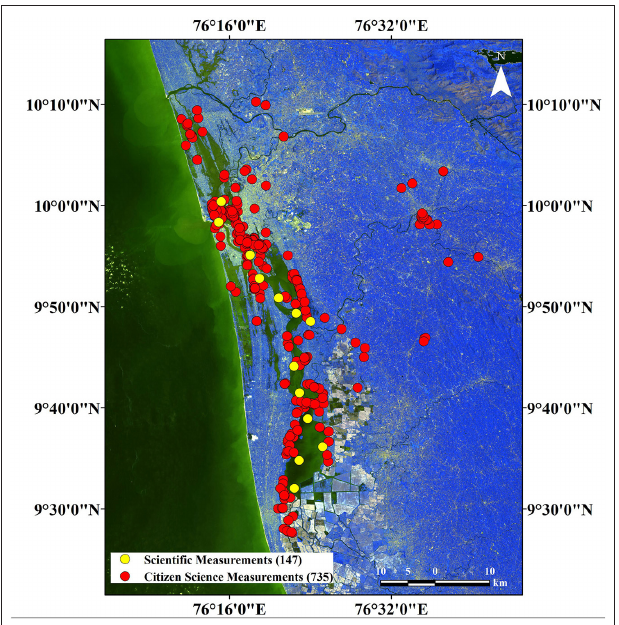
FIGURE 5 | Number of observations made by citizen scientists from each point of the lake.